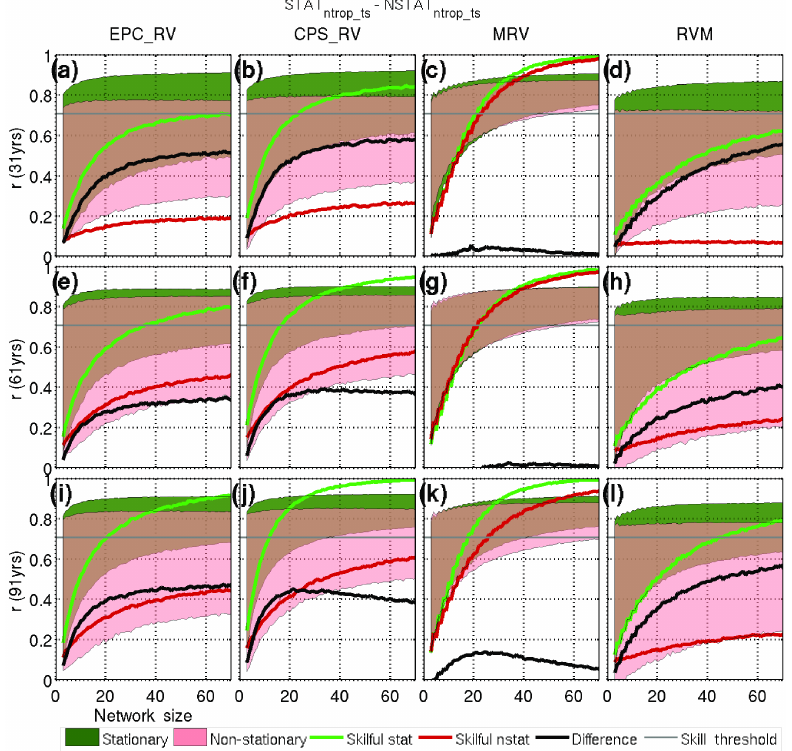
Figure 5. A comparison of reconstruction skill of the “stationary” STAT ntrop_ts (green) and non-stationary NSTAT ntrop_ts (pink) experiments. Correlation coefficients are calculated between the reconstructed running variance and ENSO running variance ( y axis), plotted against the proxy network size ( x axis). The coloured regions show the range, from the 5th to the 95th percentile, with overlapping regions shown by the brownish colouring. The thick green and red lines show the proportion of skilful reconstructions for the STAT ntrop_ts and NSTAT ntrop_ts experiments respectively. Skilful reconstructions are defined as explaining greater than 50% of explained variance (grey line). The black line is the difference in skill between the STAT ntrop (green line) and NSTAT ntrop (red line) experiments. Each row corresponds to different calibration window lengths, titled on the y axis. Each column represents different reconstruction methods, titled at the top of the